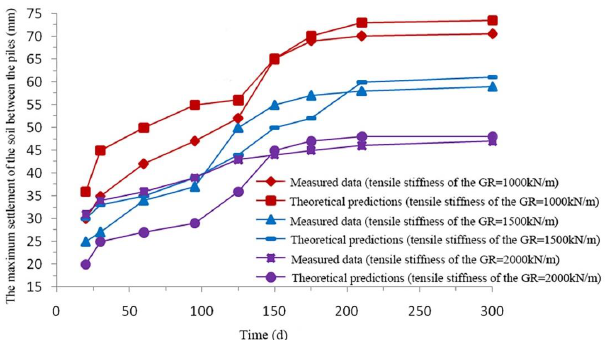
Figure 20. The time-dependent maximum settlement of the soil between the piles with different tensile stiffnesses of the GR.